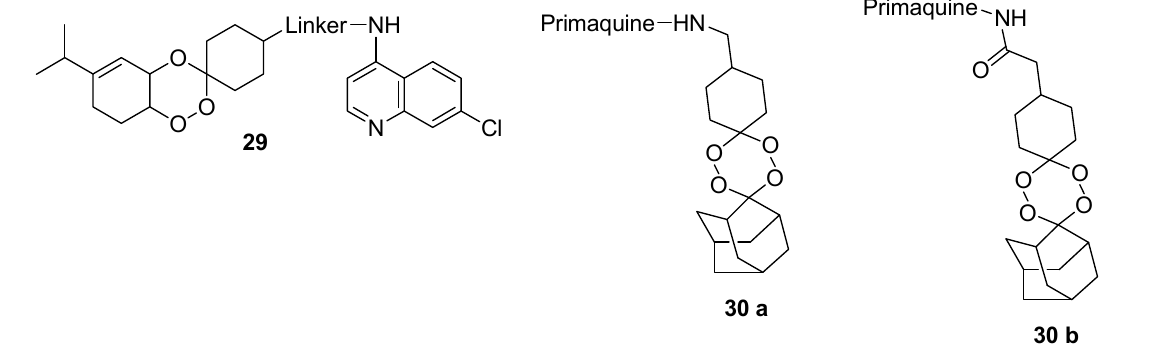
Fe 28 Figure 4. Quinoline-ferrocene hybrid compounds. 4.3. Quinoline-Trioxolanes Hybrid Compounds Araújo et al. prepared a series of quinoline-trioxolanes hybrid compounds 29 (Figure 5). The antimalarial activity against chloroquine-sensitive and -resistant strain of Plasmodium falciparum revealed that the compounds were active in the low nanomolar range [47]. Trioxaquine DU1301 was prepared from 7-chloro-4-(2-aminoethylamino)quinoline and 1,2,4-trioxane [48]. In vivo studies showed that trioxaquines cured Plasmodium infected mice after administration orally at a dosage of 15 to 20 mg/kg of body weight/day for 4 days [48,49]. Trioxaquines inhibit heme aggregation within the parasite by forming unpolymerizable heme drug adducts and by stacking the quinoline fragment